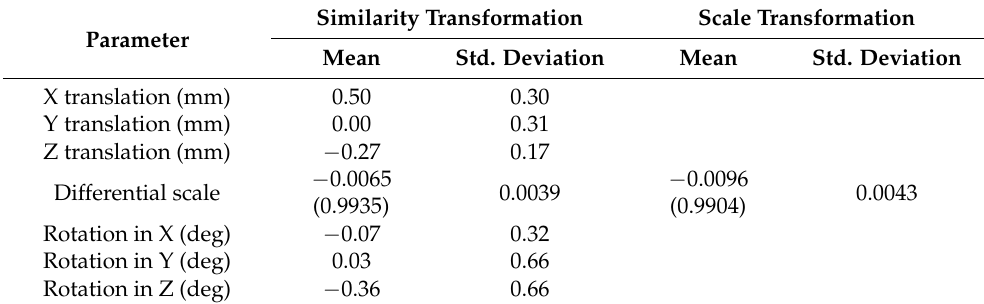
Table 2. Results of the similarity and scale transformations between PhotoMeDAS coordinates and the CNC CMM coordinates (ground truth): mean and standard deviation. The scale factor in brackets equals 1 + differential scale.